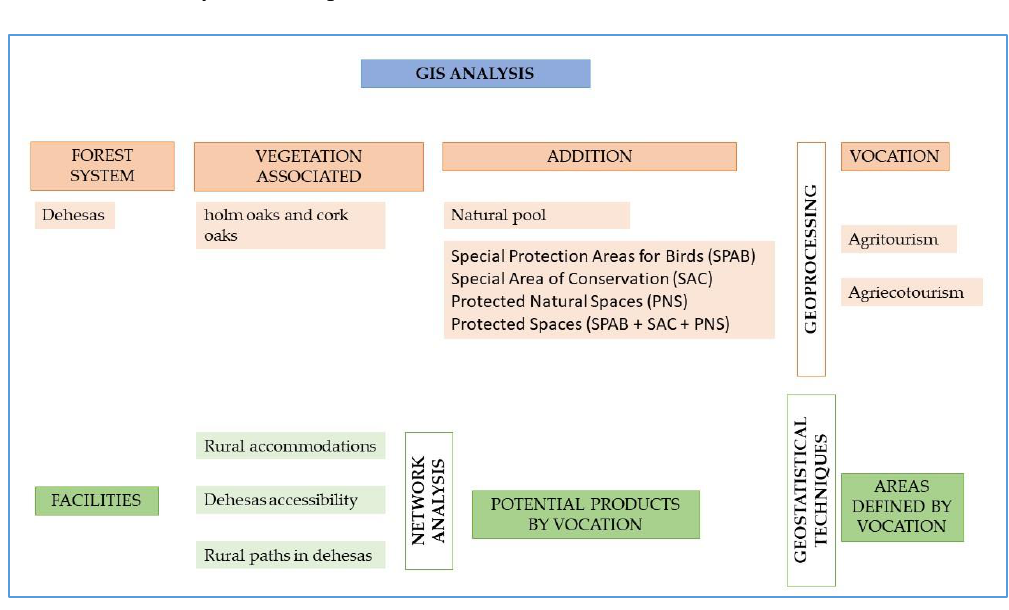
Figure 3. GIS analysis.